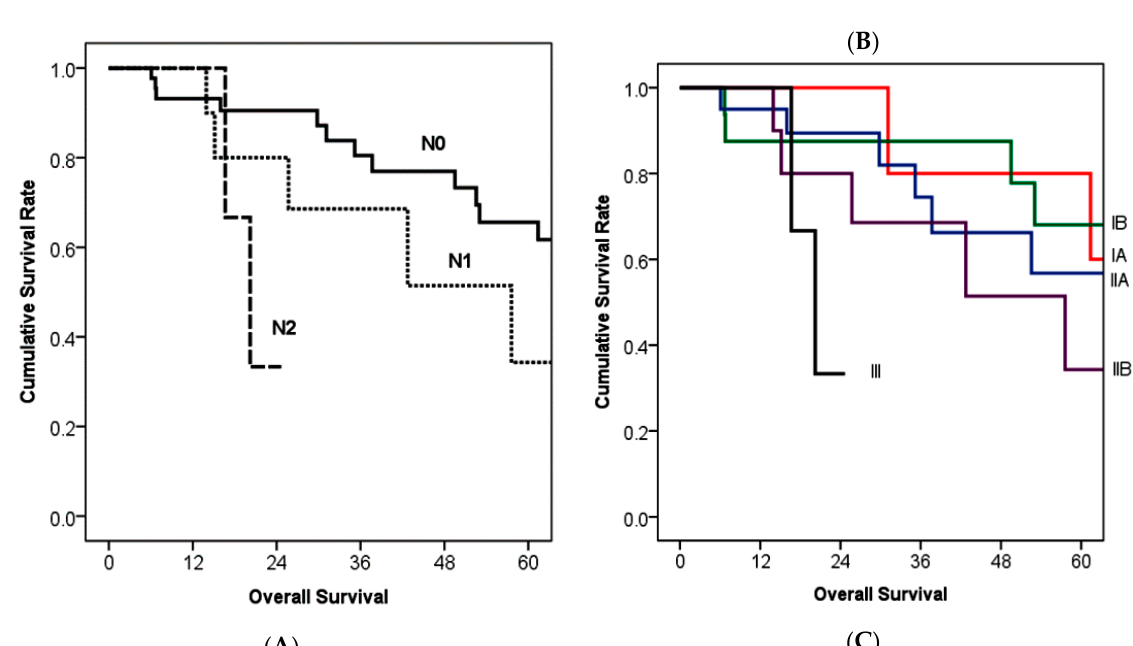
Figure 1. Kaplan–Meier survival curves of disease-free survival and overall survival ( n = 59). ( A ) The median disease-free survival was 30.9 months and the 5-year disease-free survival rate was 38.5%. ( B ) The median overall survival was 78.8 months and the 5-year survival rate was 57.4%.